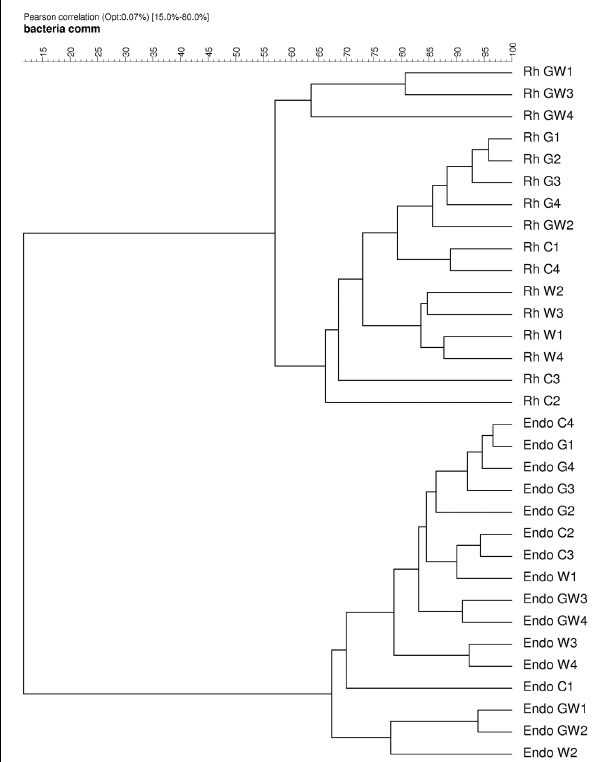
FIGURE 5 | Dendrogram constructed with the bacterial communities fingerprints in the endorhiza and rhizosphere of maize reported in Figure 4. The differences between the profiles are indicated by percentage of similarity. The dendrogram was based on the Pearson correlation indices and cluster analysis by the unweighted pair group method using arithmetic